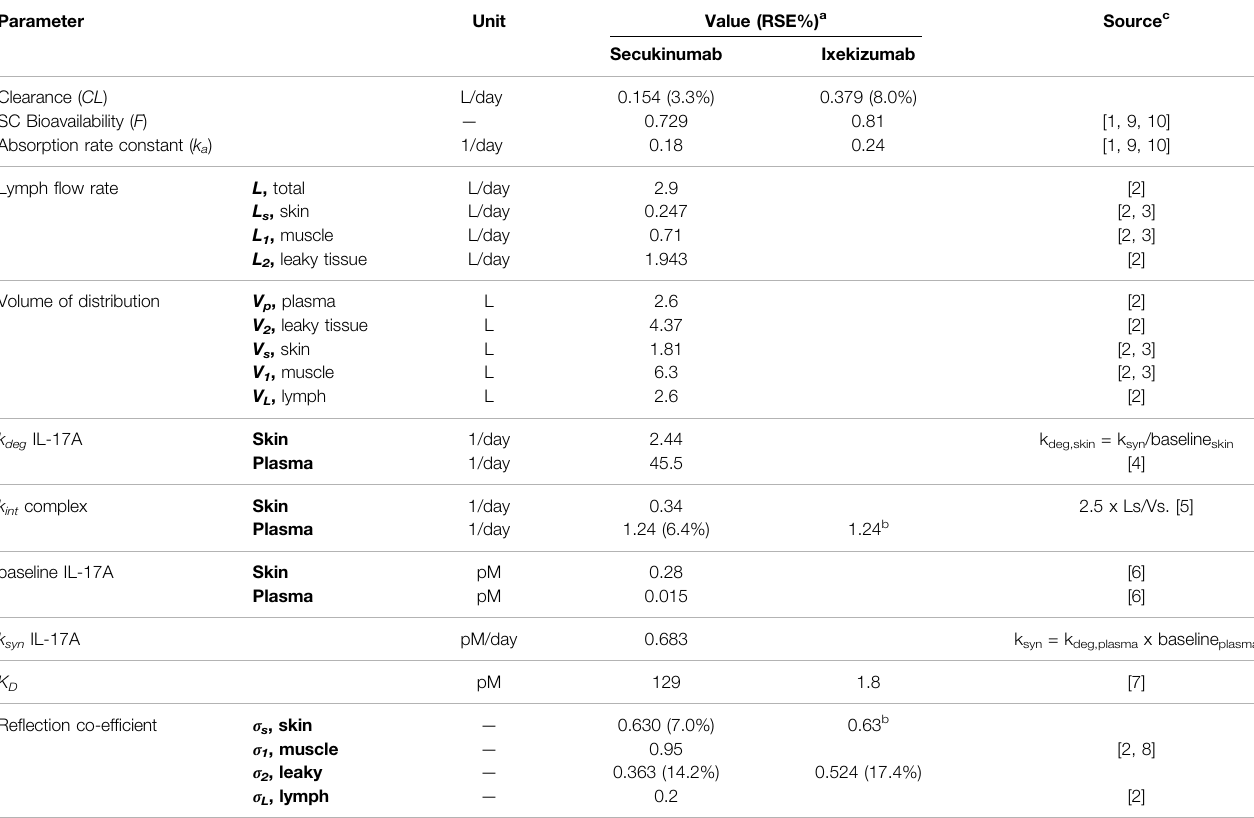
TABLE 2 | Summary of mPBPK model parameters and estimates. Parameter